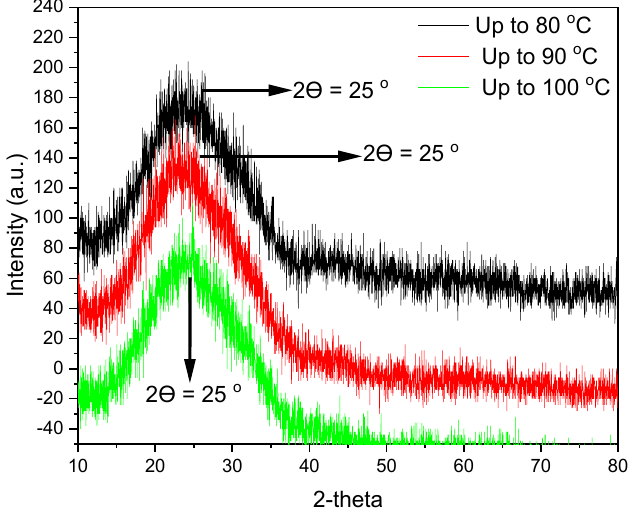
Figure 8. X-ray di ff raction (XRD) patterns of A / 2B8 at di ff erent temperatures upon cooling from the Figure 8. X-ray diffraction (XRD) patterns of A/2B8 at different temperatures upon cooling from the isotropic liquid isotropic liquid mesophase.